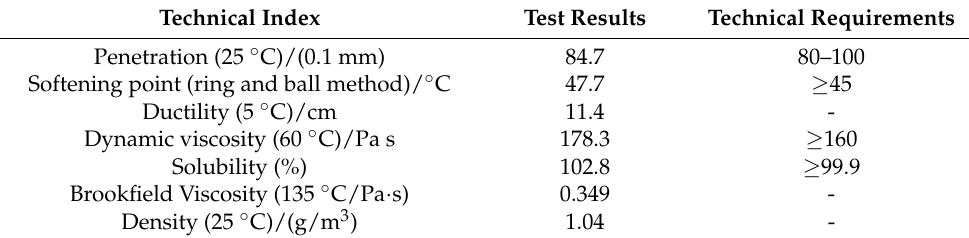
Table 2. Performance parameters of SK-90 base asphalt.